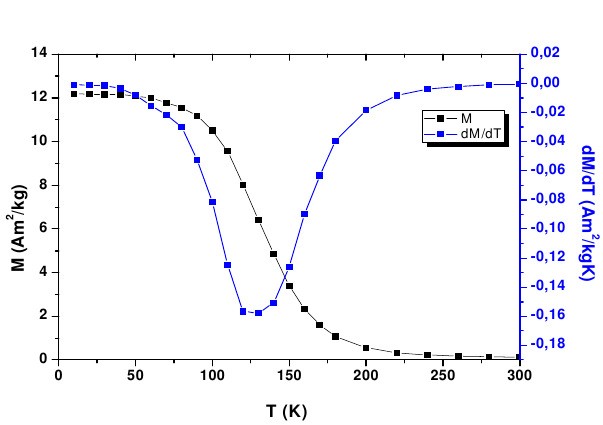
Fig.3: Temperature dependence of magnetization and its derivate for La 0.4 Eu 0.1 Ca 0.5 MnO 3 simple at a magnetic applied field of 500 Oe